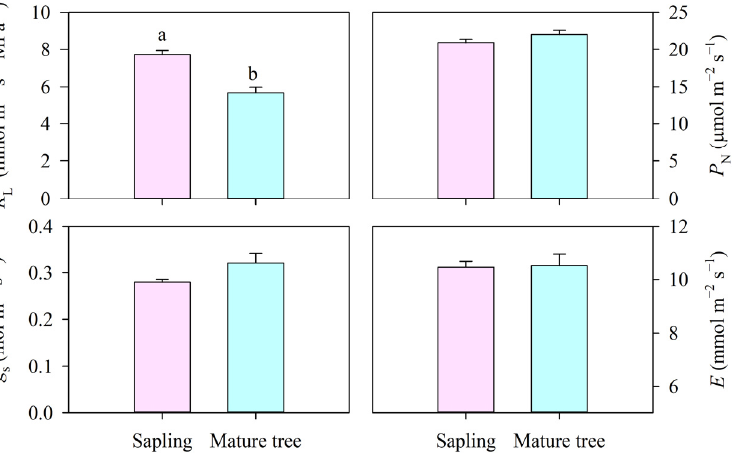
Figure 4. The leaf ‐ specific apparent hydraulic conductance ( K L ), net photosynthesis rate ( P N ), stomatal conductance ( g s ), and transpiration rate ( E ) of P. euphratica of different sizes. Vertical bars represent the standard error of the means ( n = 5). Different letters at each column denote significant differences between the saplings and the mature trees ( p < 0.05).